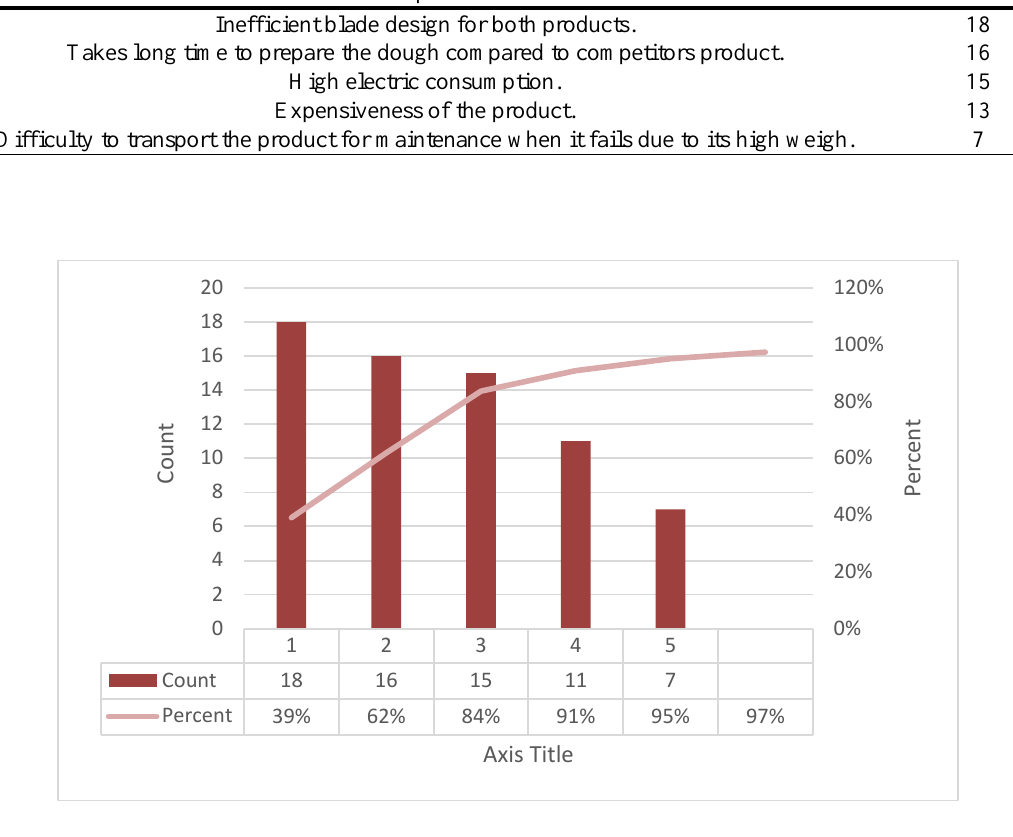
Figure 2. Pareto chart to select a focused